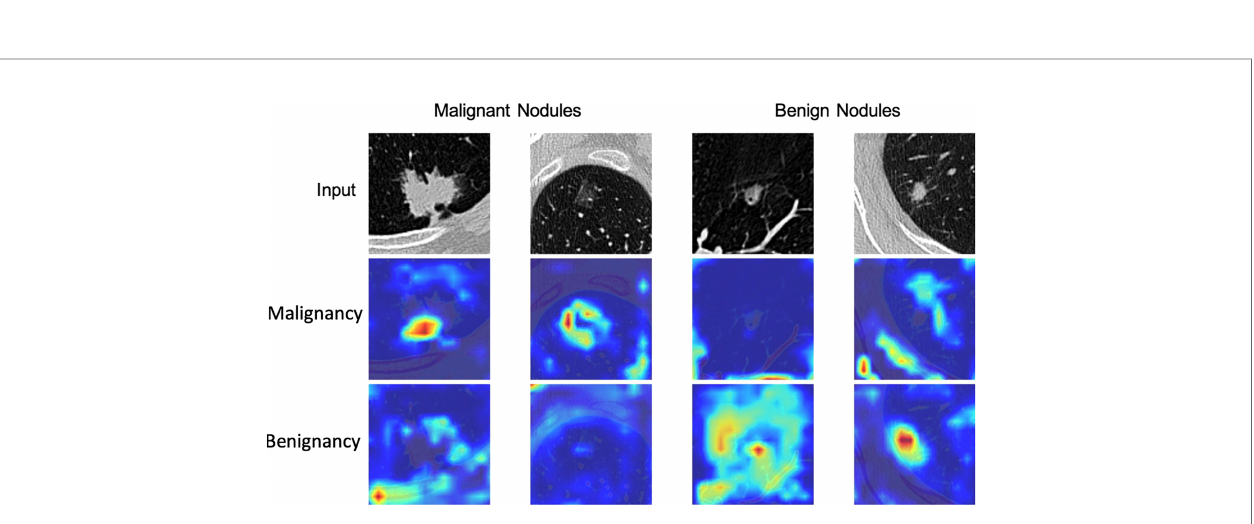
FIGURE 5 | Attention map of DeepLN model in the triage of benign and malignant